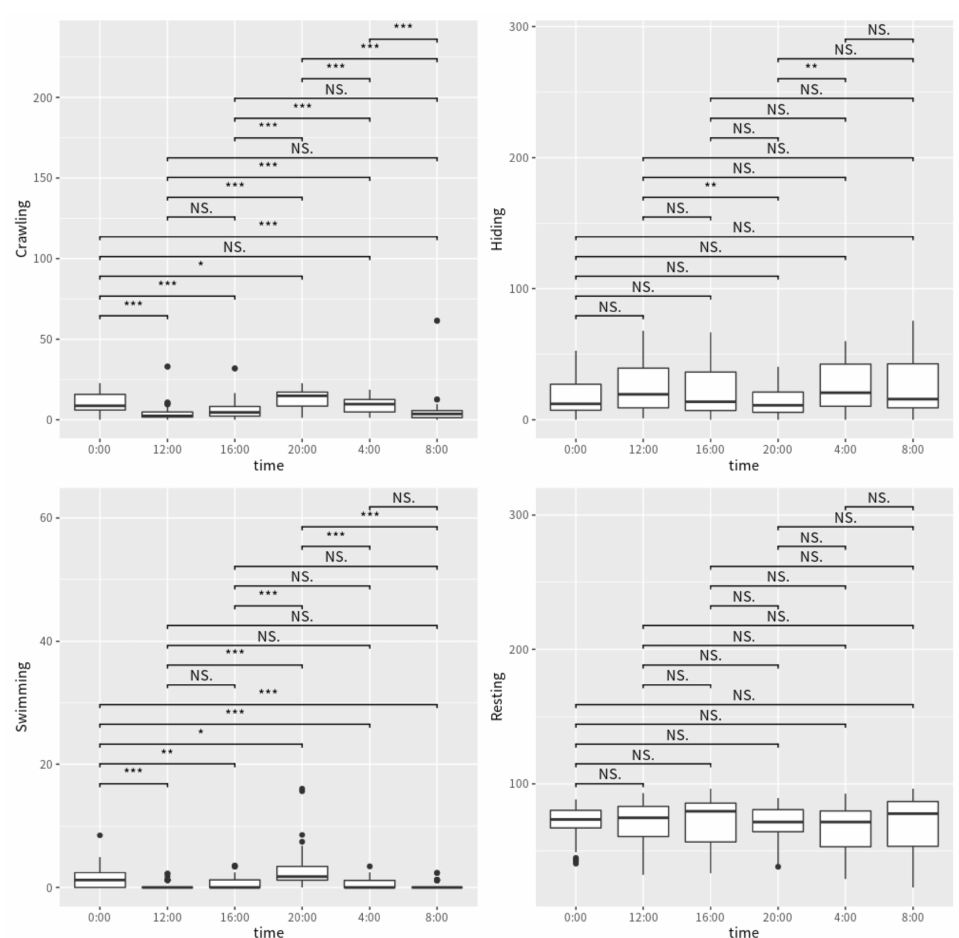
Figure 1. Differences in the proportion of crawling, hiding, swimming, and resting behavior of P. japonicus at different time points. Note: NS, represents no significant difference ( p > 0.05); * represents significant difference (0.005 < p < 0.05); ** and *** represent highly significant difference ( p <